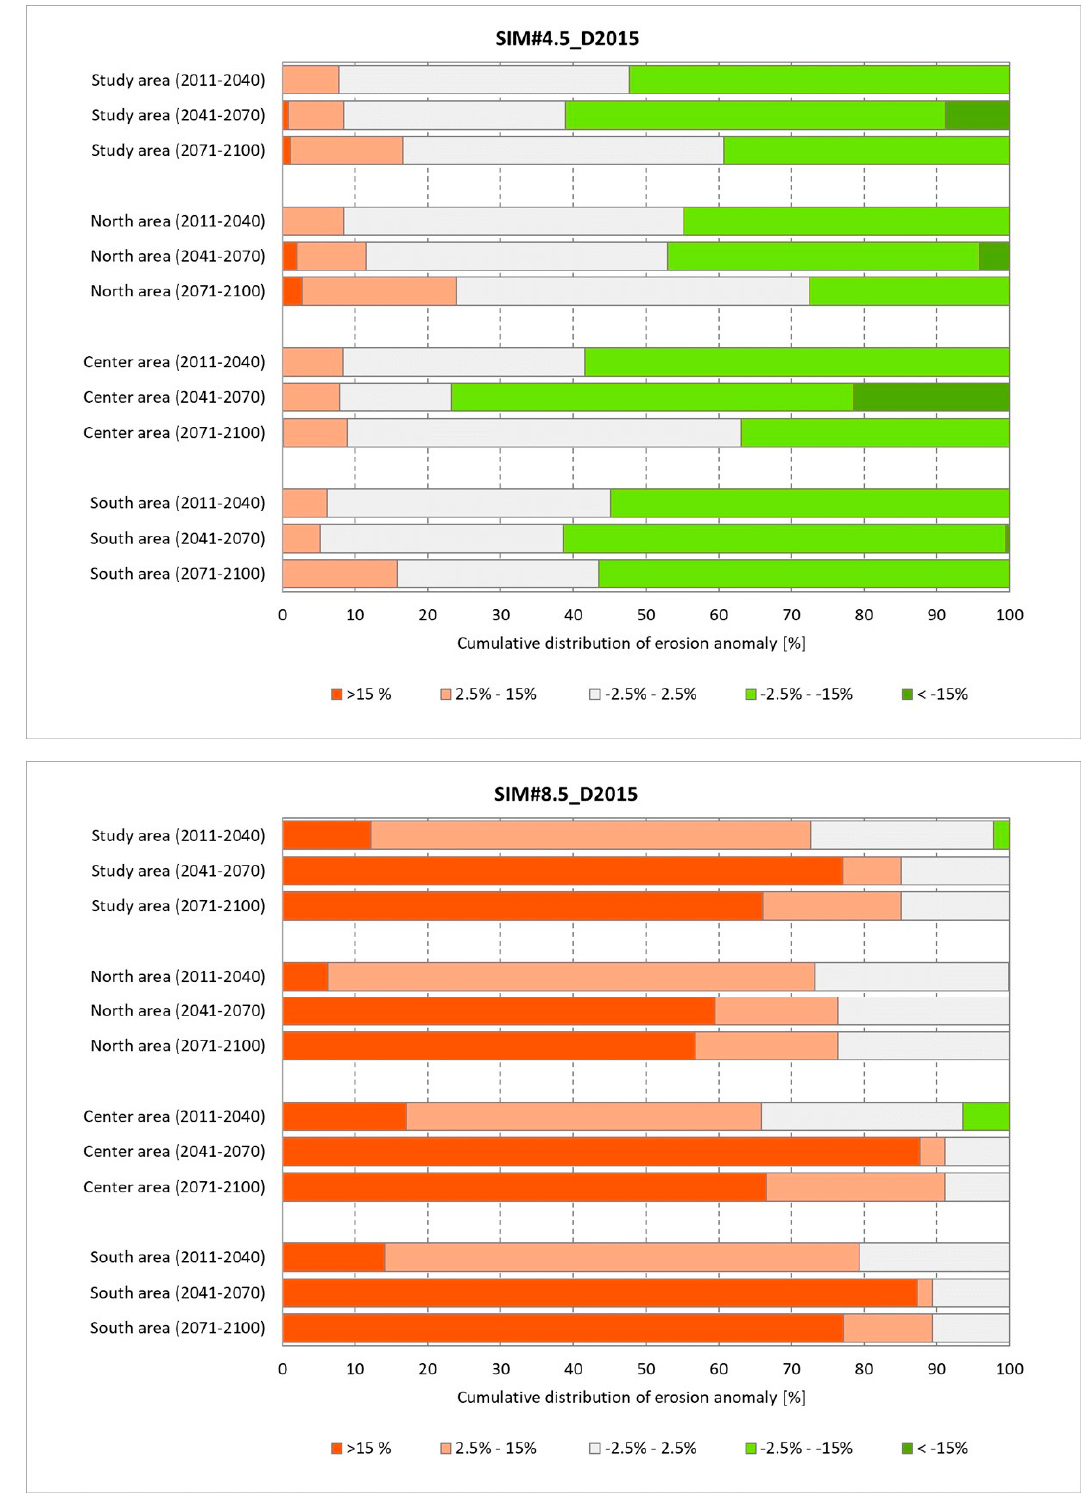
Figure 14. Erosion anomaly with respect to the reference period (1981–2010) expressed as percentage of territory for SIM#4.5_D2015 (on the top) and SIM#8.5_D2015 (on the bottom).